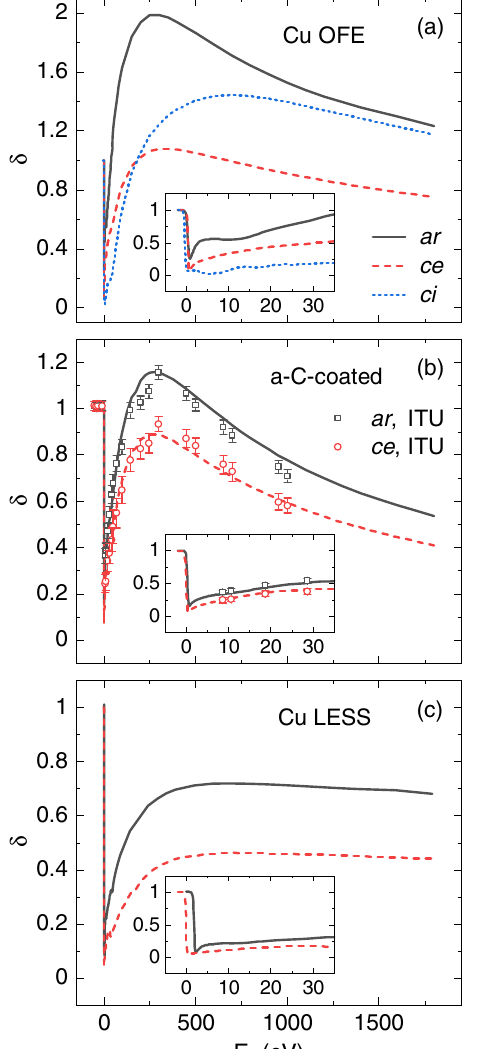
FIG. 4. Secondary-electron yield ( δ ) as a function of the primary energy ( E ) obtained at CERN for all types of samples p Þ for Cu OFE surfaces. (b) Like (a), studied in this work. (a) δ ð E p for a-C-coated samples. For comparison, ITU data are plotted as open symbols. The uncertainty margins reflect the experimental uncertainties in the measured sample current. (c) Like (a), for Cu LESS samples. The insets to each panel depict the low-energy < 35 eV) region of δ ð E Þ ( 0 eV < E p p